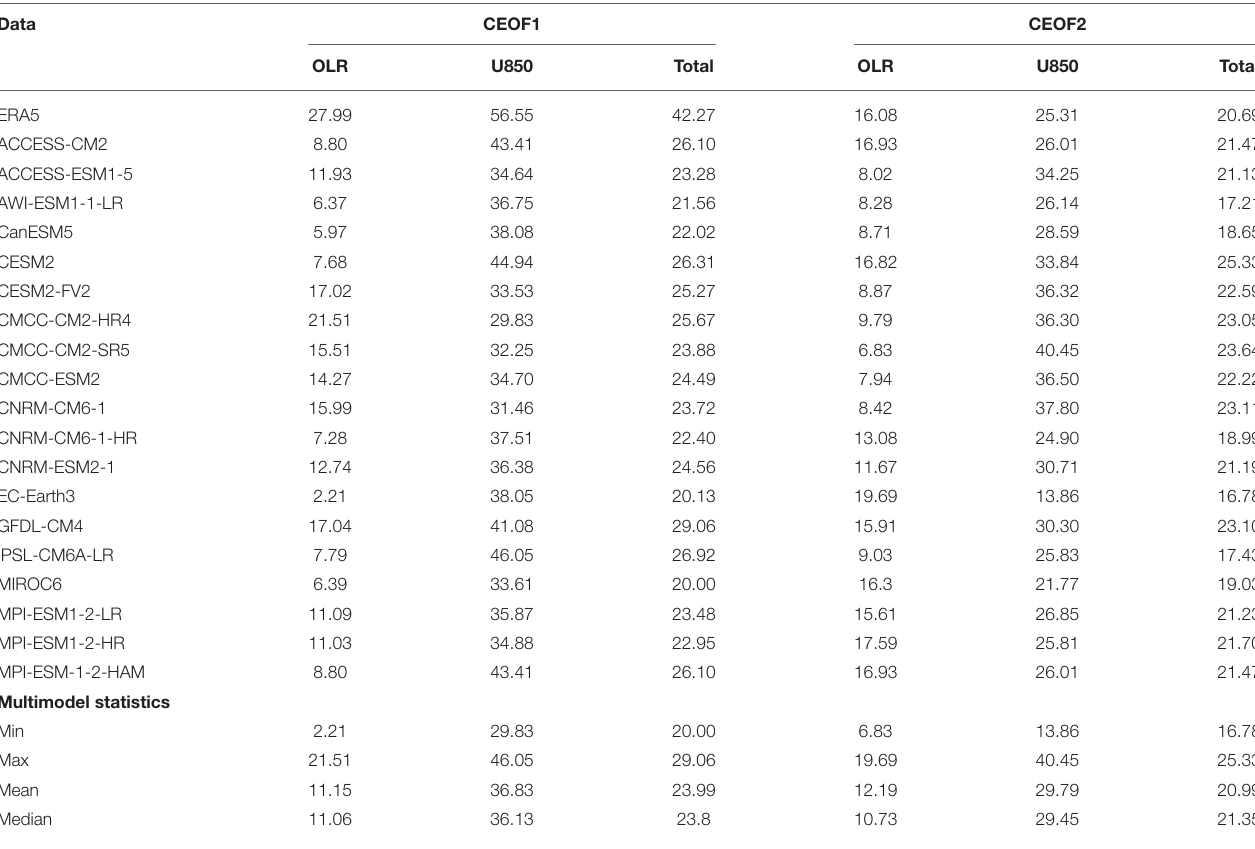
TABLE 3 | Variance explained by the combined empirical orthogonal